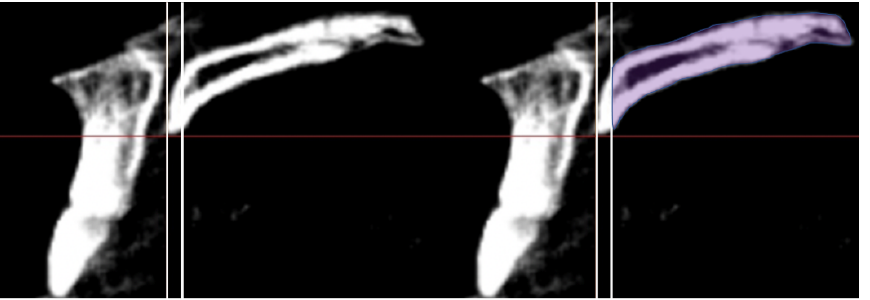
Figure 3. Using the “create graft volume” function, bone density was measured. The area was selected manually along the bone border.